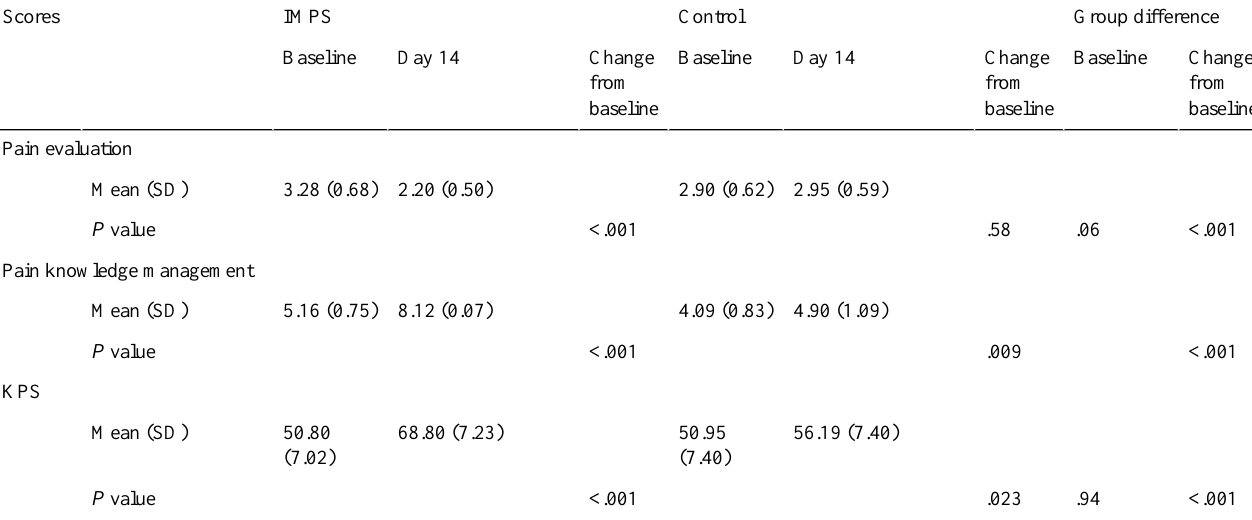
Table 3. Pain management and KPS score comparisons between IPMS and control groups.